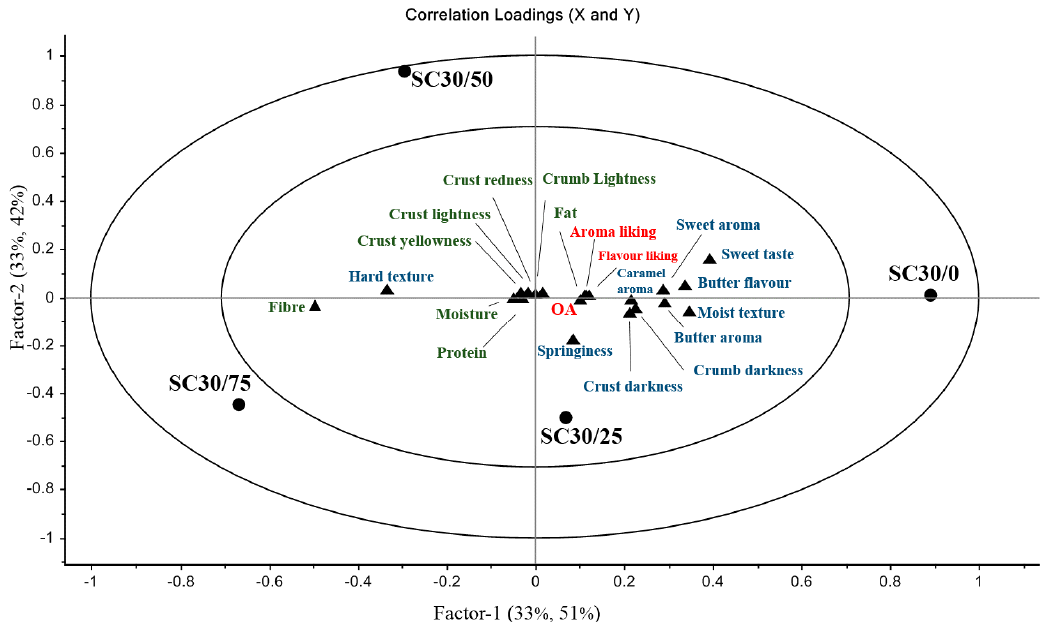
Figure 4. Partial least squares regression (PLSR) plot for the relationship between reduced sugar sponge cake (30%) prepared with increasing levels of fat replacement: 0, 25, 50 and 75%, sensory and physicochemical variables, hedonic and intensity sensory terms and physicochemical parameters.